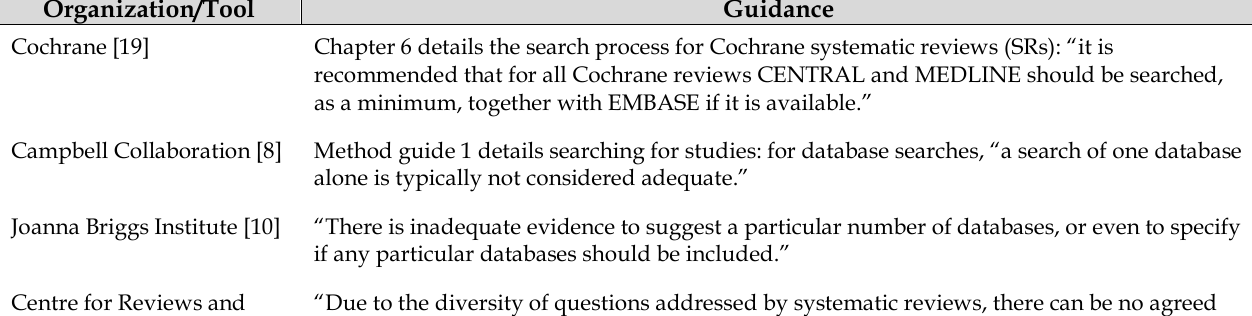
Table 1 Recommendations for systematic review searching from guidelines and checklists